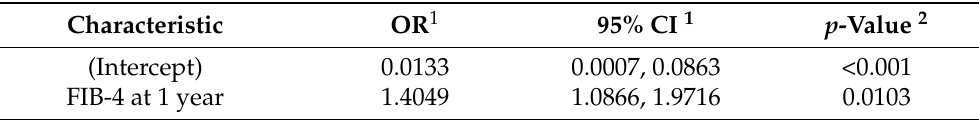
Table A5. The summary of the model ascites and GI bleeding vs. FIB-4 at 1 year presented in Figure 6. Logistic model for rare events (Firth method, penalized method). Likelihood ratio test = 6.5676 on